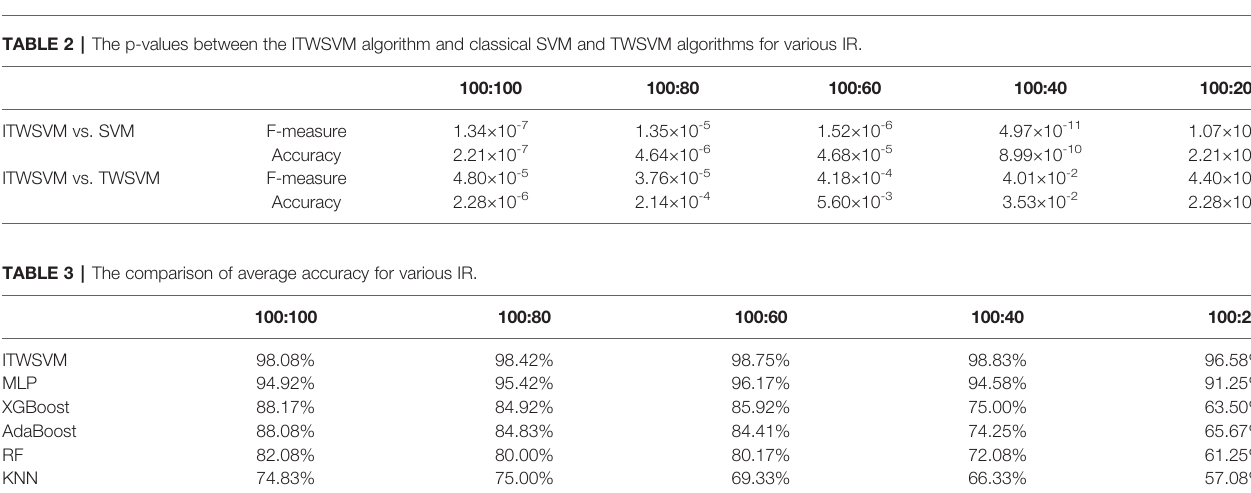
TABLE 4 | The comparison of average F-measure for various IR.